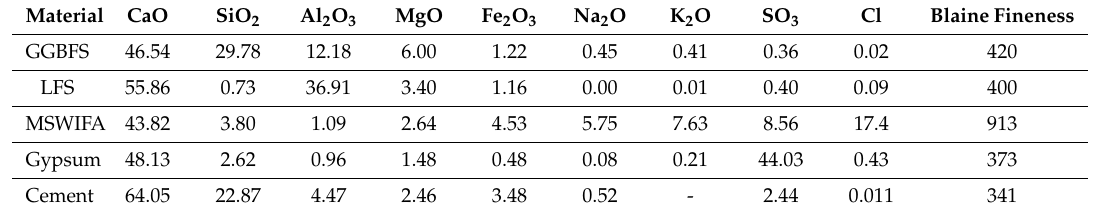
Table 1. Chemical composition (mass %) and Blaine fineness (m 2 / kg) of the raw materials [21]. Material CaO